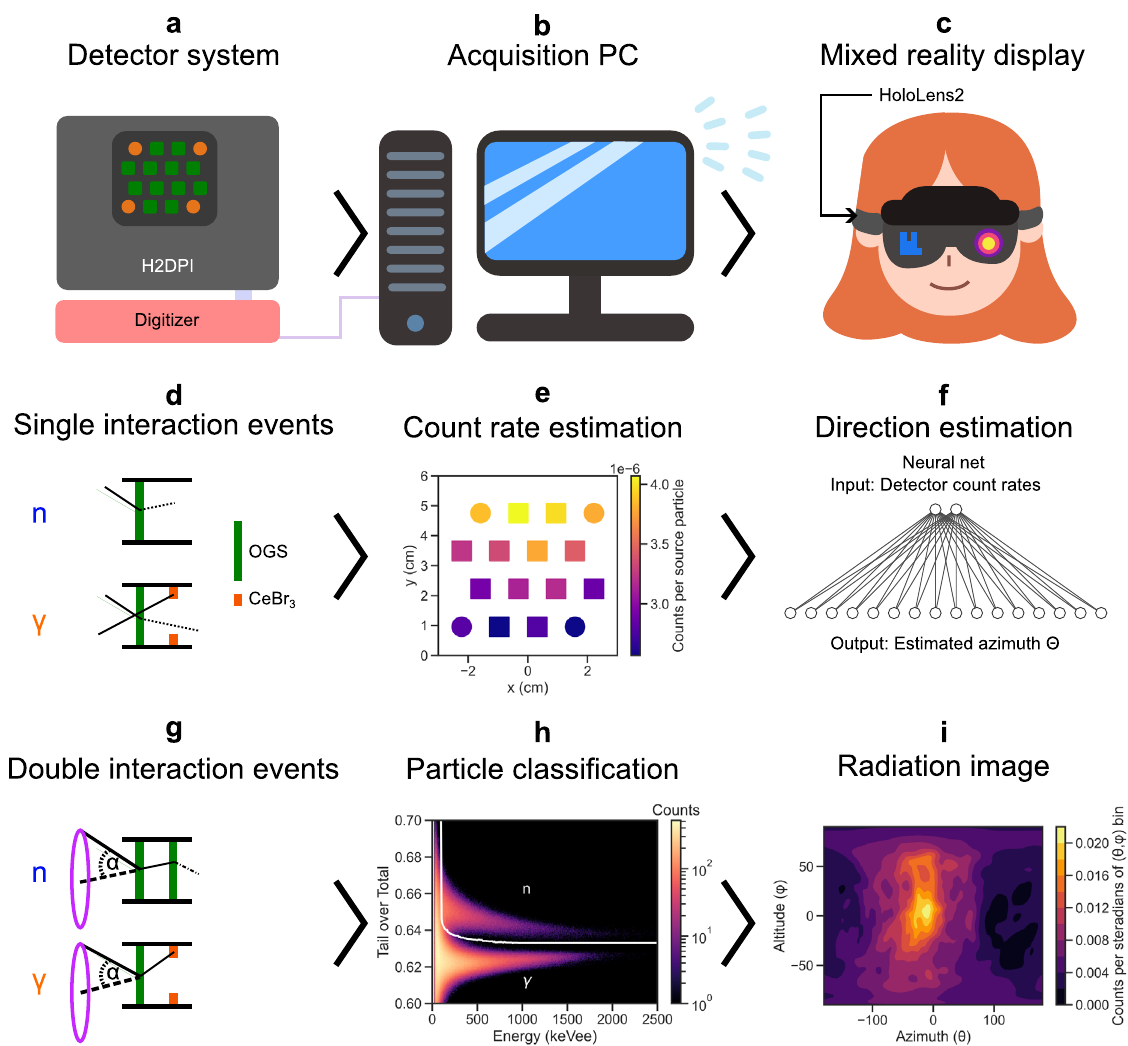
Figure 2. Overview of the data processing from particle interactions to MR display. ( a ) Radiation interactions in the H2DPI detector system are observed via SiPM arrays that are connected to a digitizer. ( b ) Acquired waveforms are sent to the acquisition PC in regular intervals over an optical wire, where they are filtered and sent over WiFi to the HoloLens2. ( c ) The HoloLens2 projects the data into the users field of view. Single events ( d ) can be used to estimate total count rates in each detector (i.e., both neutrons and gamma rays), which show a specific shape depending on the source’s azimuthal location ( e ). The average count rates per detector are given as inputs to a pre-trained neural network ( f ) that predicts the azimuth of the source, showing an arrow to the user. Double-scatter events in two different detector volumes ( g ) allow for the reconstruction of the detected particle’s incidence cone with opening angle α . Subsequent particle classification of the individual events in the organic glass scintillator (OGS) via pulse shape discrimination ( h ) enables the differentiation between neutron-neutron and gamma-gamma incidence cones. A discrimination line between the pulse shape clusters (white) is found via fitting a double Gaussian into each energy equivalent slice and taking the valley as the decision threshold. Using a back projection algorithm the cones are overlaid to create the radiation image ( i ) in angular space (Azimuth (cid:31) , Altitude (cid:31) ) for either gamma rays or fast neutrons. The user is then shown a 3D projection of the image in